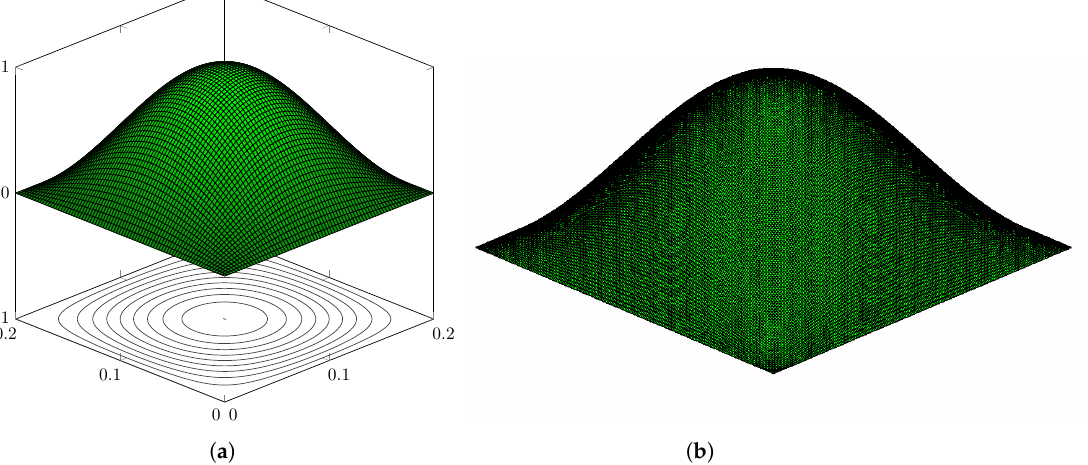
Figure 4. Simply supported LRMP in Figure 3, real part of Mode 127: ( a ) dynamic-stiffness approach and ( b ) finite-element